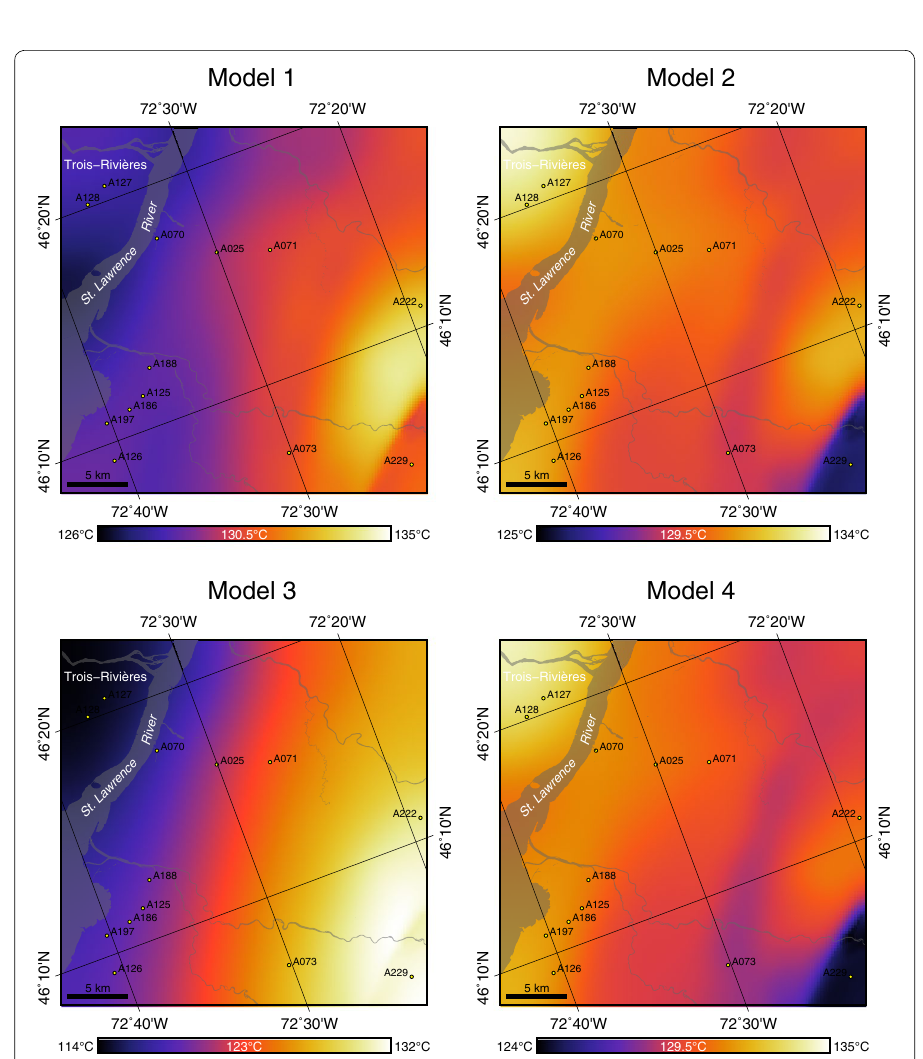
Fig. 7 Temperature distribution at 5 km for models with a homogeneous